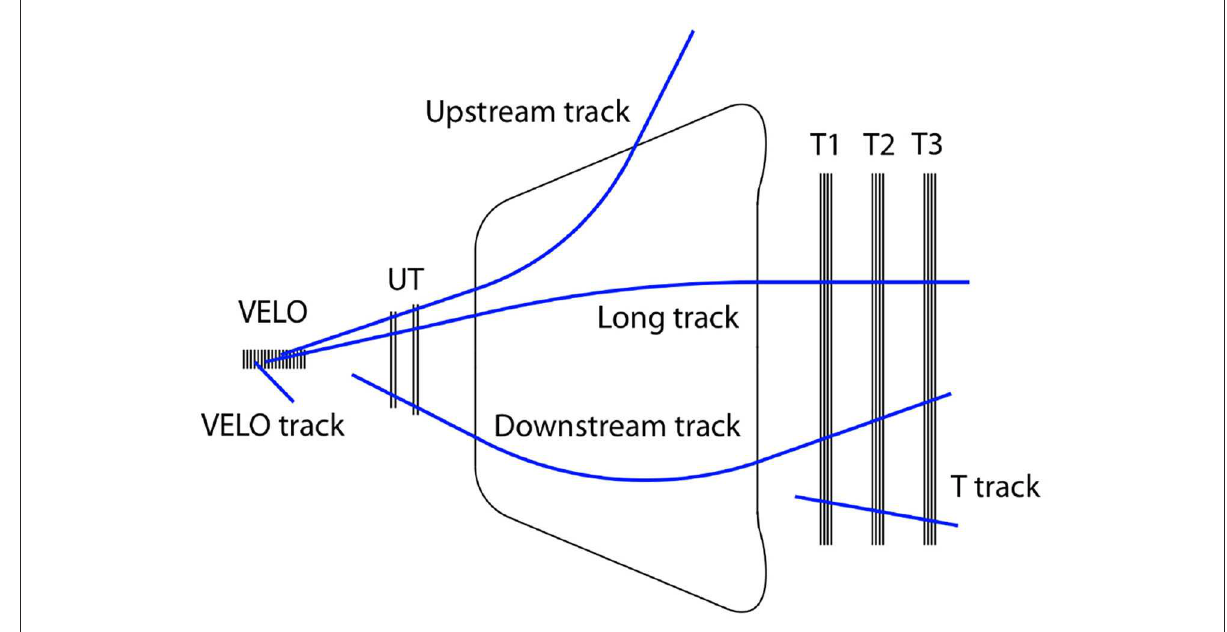
FIGURE3 Track types in LHCb, as defined in LHCb (2014a).